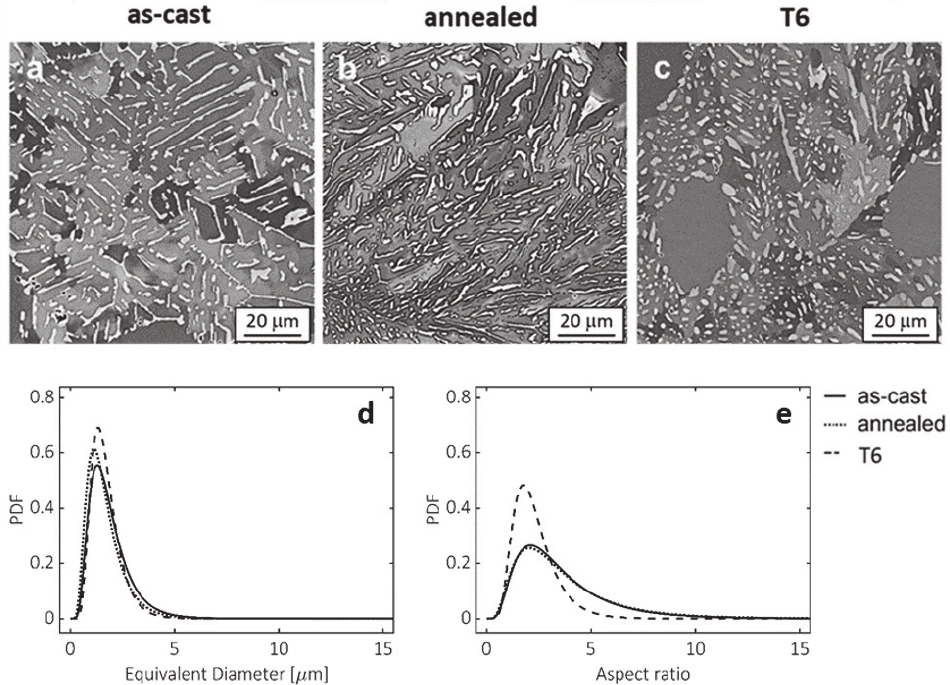
Figure 4: Effect of heat treatment at atmospheric pressure on the eutectic Si: (a) as-cast condition, (b) annealed condition, (c) T6 conditions, (d) distribution of the values of particles’ equivalent diameter, (e) distribution of the values of the particles’ aspect ratio.